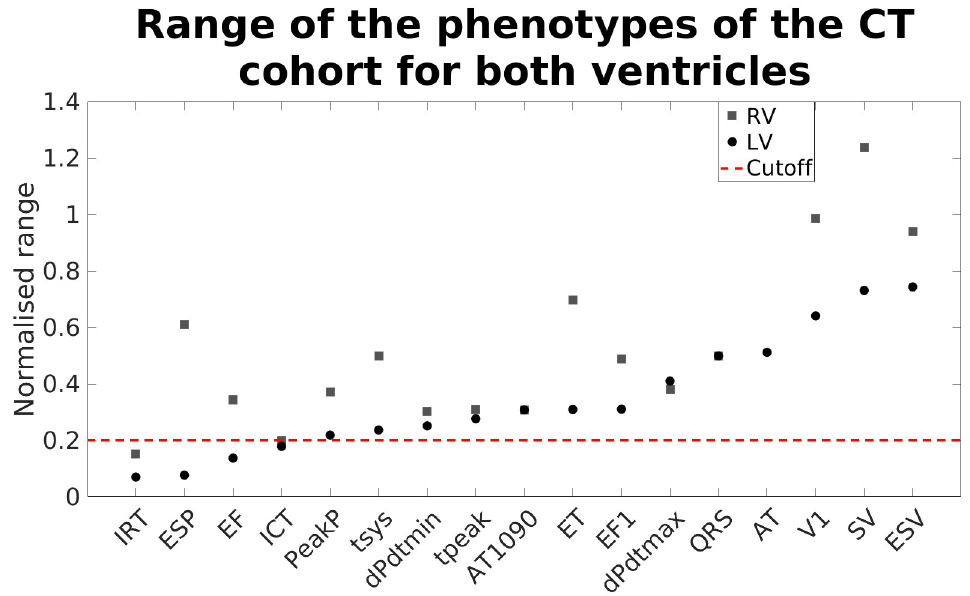
Fig 6. Range covered by each one of the simulated phenotypes of the CT cohort for both ventricles, normalised with the average value of each one of them. The discontinuous red line marks the threshold chosen to discard the simulated phenotypes. In these cases, the range of functional change was considered too small for further study.